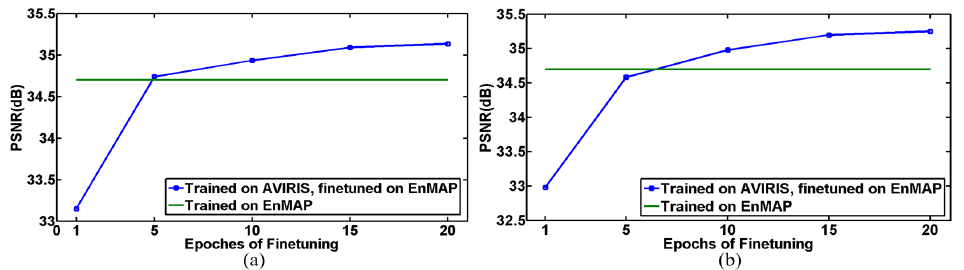
Figure 16. Evolution of fusion performance over epochs of fine-tuning, the testing data is EnMAP Berlin data, ( a ) the first and last FC layers are fine-tuned on EnMAP; ( b ) all of the three FC layers are fine-tuned on EnMAP.